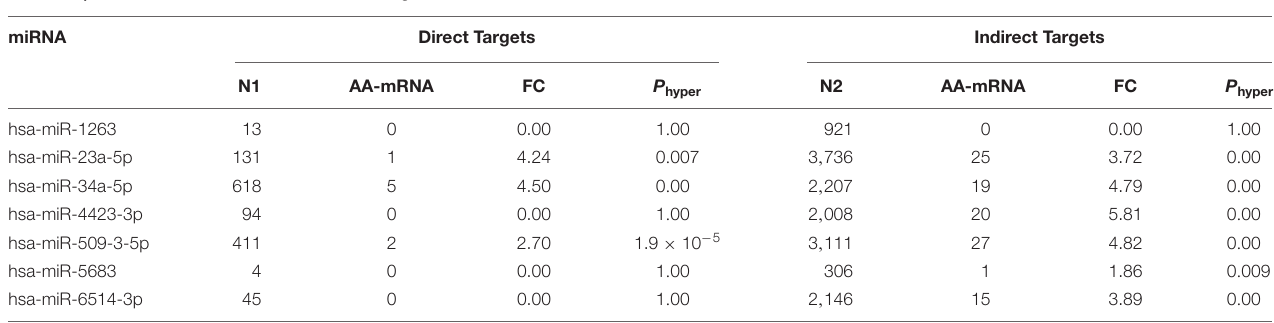
TABLE 2 | Prediction of AA-miRNA Downstream